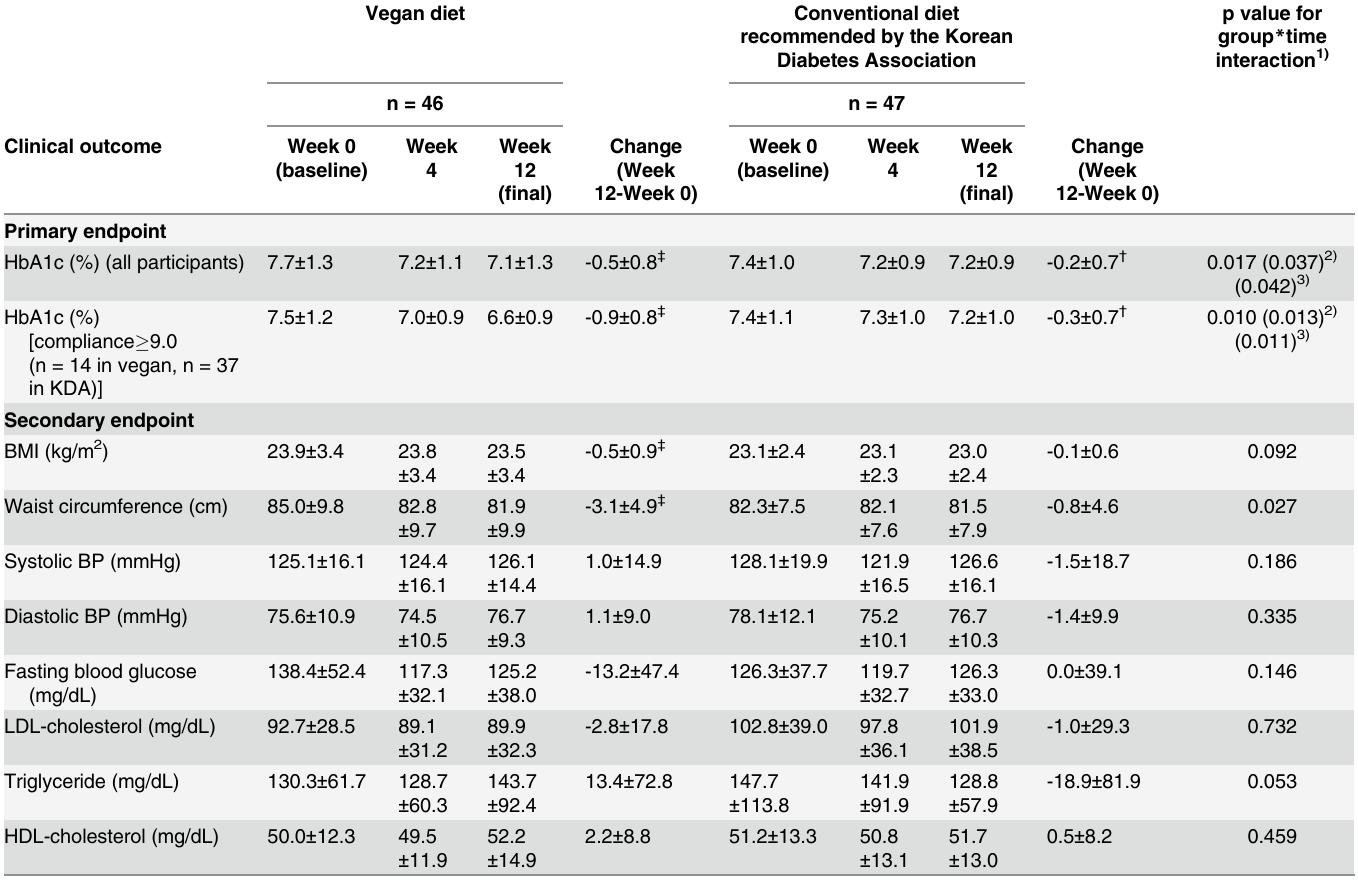
Table 3. Clinical outcomes of the study participants following a vegan or conventional diet at baseline, and after the fourth and twelfth